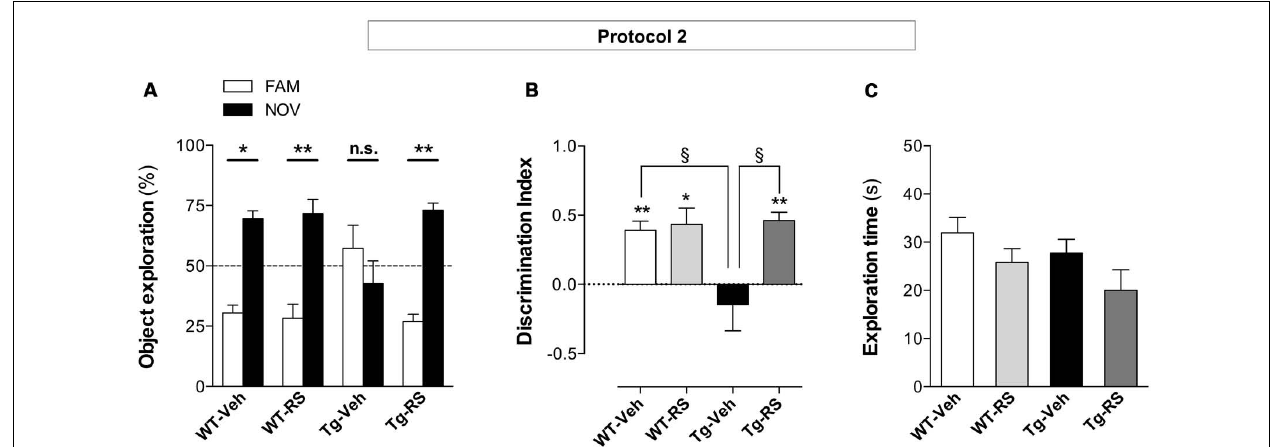
FIGURE 6 | Chronic administration of RS 67333 prevents object recognition memory loss in 5XFAD mice. Two-month-old 5XFAD females (Tg) andWT littermates were treated with RS 67333 or vehicle according to protocol 2 (1 mg/kg, twice a week for 2 months) and then recognition memory was assessed with the novel object recognition (NOR) test. Habituation sessions were started 3 days after the end of treatment and the interval between training session and test was of 1 h. (A) RS 67333-treatment reverses cognitive impairment as indicated by the higher percentage of time